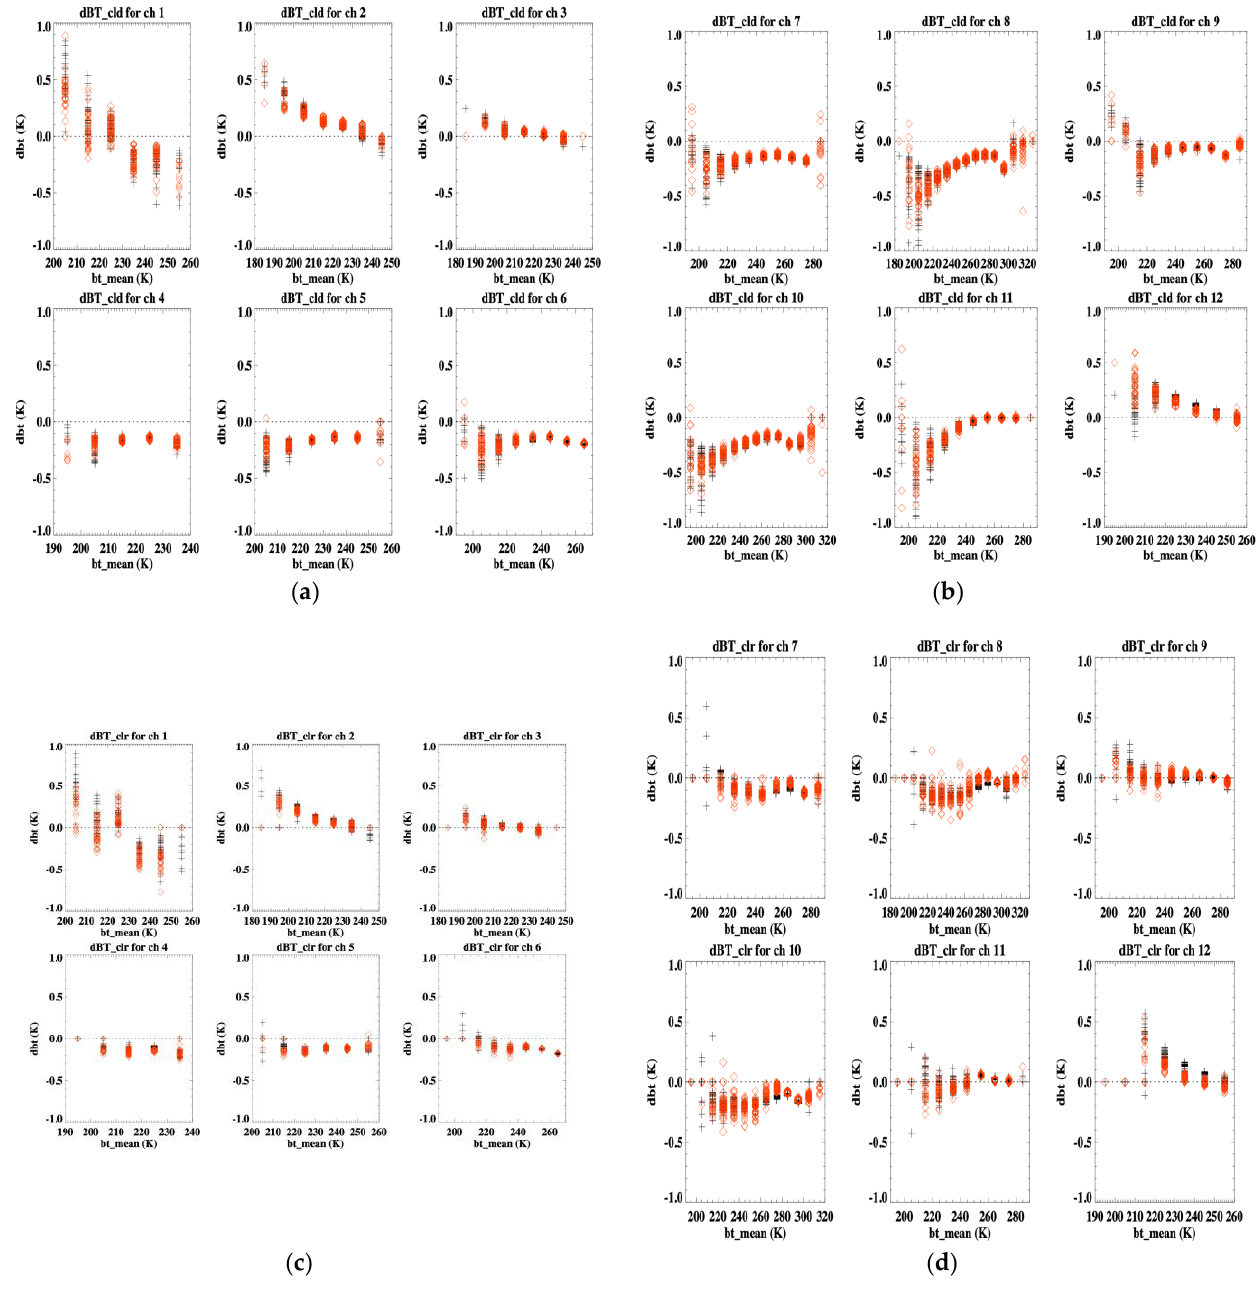
Figure 7. ( a ) Difference in brightness temperatures (dBT) between IHIRS and HIRS as a function of BT range (10 K intervals) for channels 1 – 6 for cloudy (>10% cloud) case. Each data point (black for ascending and red for descending orbits) represents a 3 year median value for 1 month. ( b ) Same as in ( a ), but for channels 7 – 12. ( c ) Same as in ( a ), but for clear (<10% cloud) skies. ( d ) Same as in ( c ), but for channels 7 – 12.